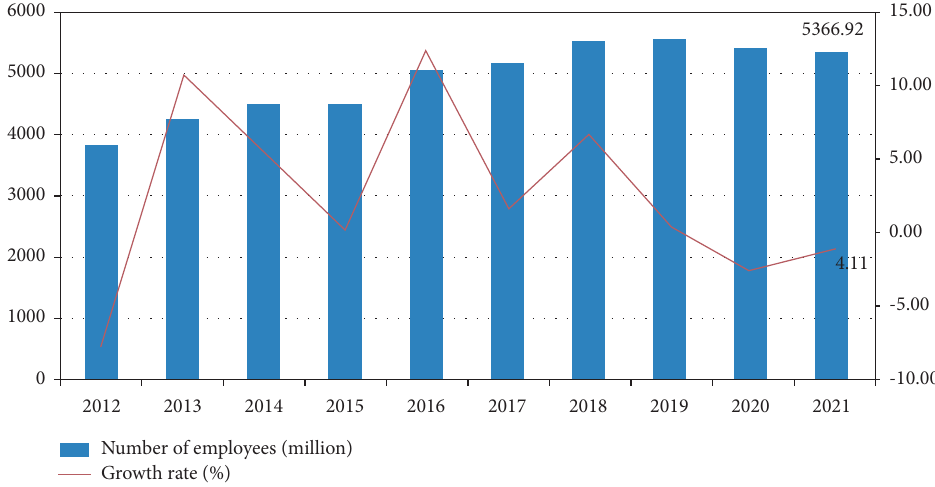
Figure 4: Growth of construction industry employees. Source: National Bureau of Statistics (NBS)